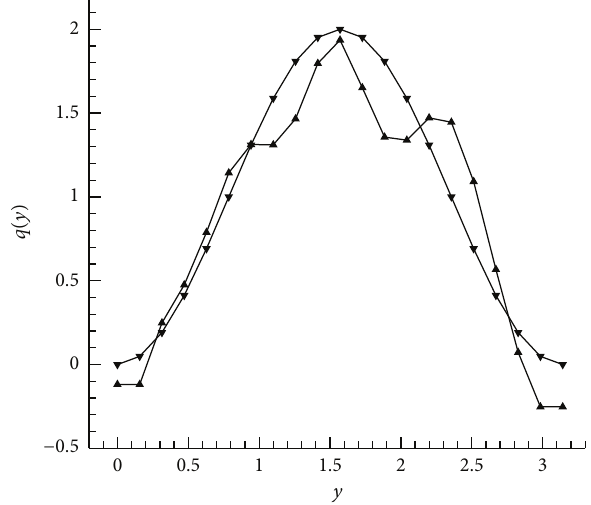
Figure 2: 󳶃 indicates exact solution 𝑞(𝑦) ; 󳵳 indicates solution obtained by the Tikhonov